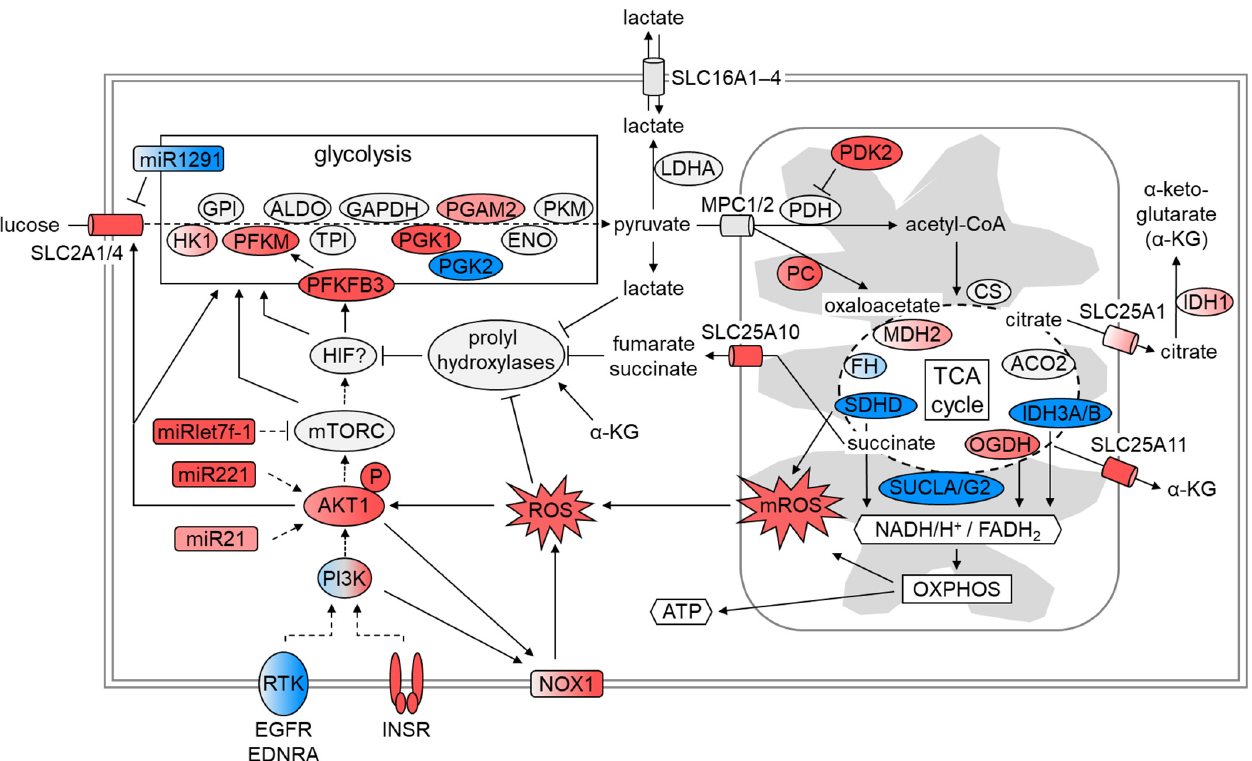
Figure 9. Molecular changes driving the Warburg effect. Downstream from the insulin receptor (INSR), phosphatidylinositol 3-kinase (PI3K) activates protein kinase B (AKT) stimulating the mechanistic target of rapamycin complex (mTORC), a protein kinase complex altering metabolism directly or via hypoxia-inducible factor 1 (HIF-1). mTORC and HIF-1 stimulate the expression of glucose transporters (GLUT), glycolytic enzymes, and pyruvate dehydrogenase kinase (Pdk2) that blocks the pyruvate dehydrogenase complex (Pdh). By blocking Pdh, the entry of pyruvate into the tricarboxylic acid (TCA) cycle is reduced. Alternatively, pyruvate is catalyzed by lactate dehydrogenase A (Ldha) to lactate. Lactate stabilizes HIF-1, whose accumulation leads to the increased gene expression of glycolytic enzymes and glucose transporters. Lactate after efflux via monocarboxylate transporter 4 (MCT4) accumulates in the cell supernatant. Additionally, the expression of several genes encoding TCA enzymes is reduced, leading to the accumulation of several TCA substrates in the cytosol that, again, can influence the stability of HIF-1. The red color indicates genes with increased mRNA levels and the blue color indicates those with decreased mRNA levels as compared with pIRES controls ( q < 0.05, fold change ≥ |1.3|), while the gray color indicates not significantly altered genes with q > 0.05 or fold change < |1.3|.